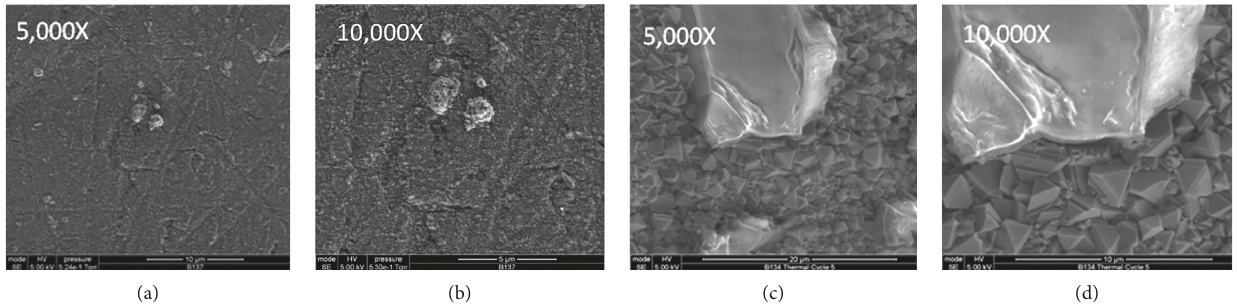
Figure 11: Sample Al2O3-B137 before and after thermal cycling. (a) Before thermal cycling, shown at 5,000X. (b) Before thermal cycling, shown at 10,000X. (c) After thermal cycling, shown at 5,000X. (d) After thermal cycling, shown at 10,000X. The nonthermally cycled sample EDX shows only iron (Fe), aluminum (Al), silica (Si), carbon (C), and oxygen (O). Fe, Si, and C are in the substrate. No Cr or Ni was detected.